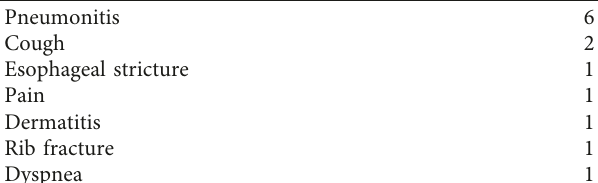
Table 4: Radiation-associated side